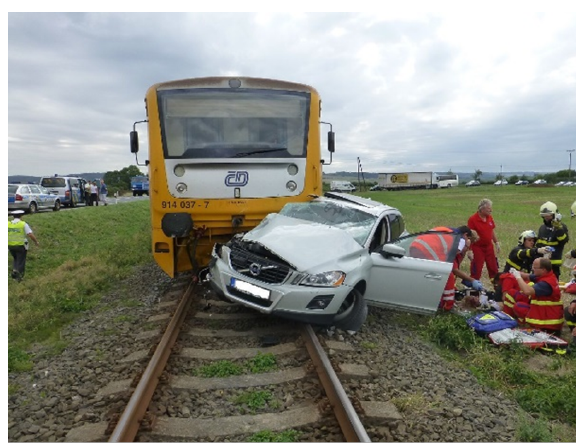
Figure 1. Train accident with a road motor